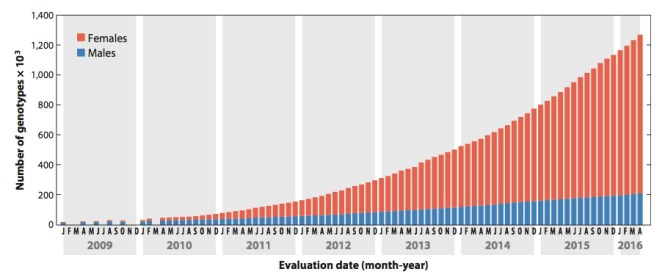
The number of genotyped animals included in US genomic evaluations for dairy cattle since January 2009 (Data sourced from the Council on Dairy Cattle Breeding, 2016; Wiggans et al., 2017).